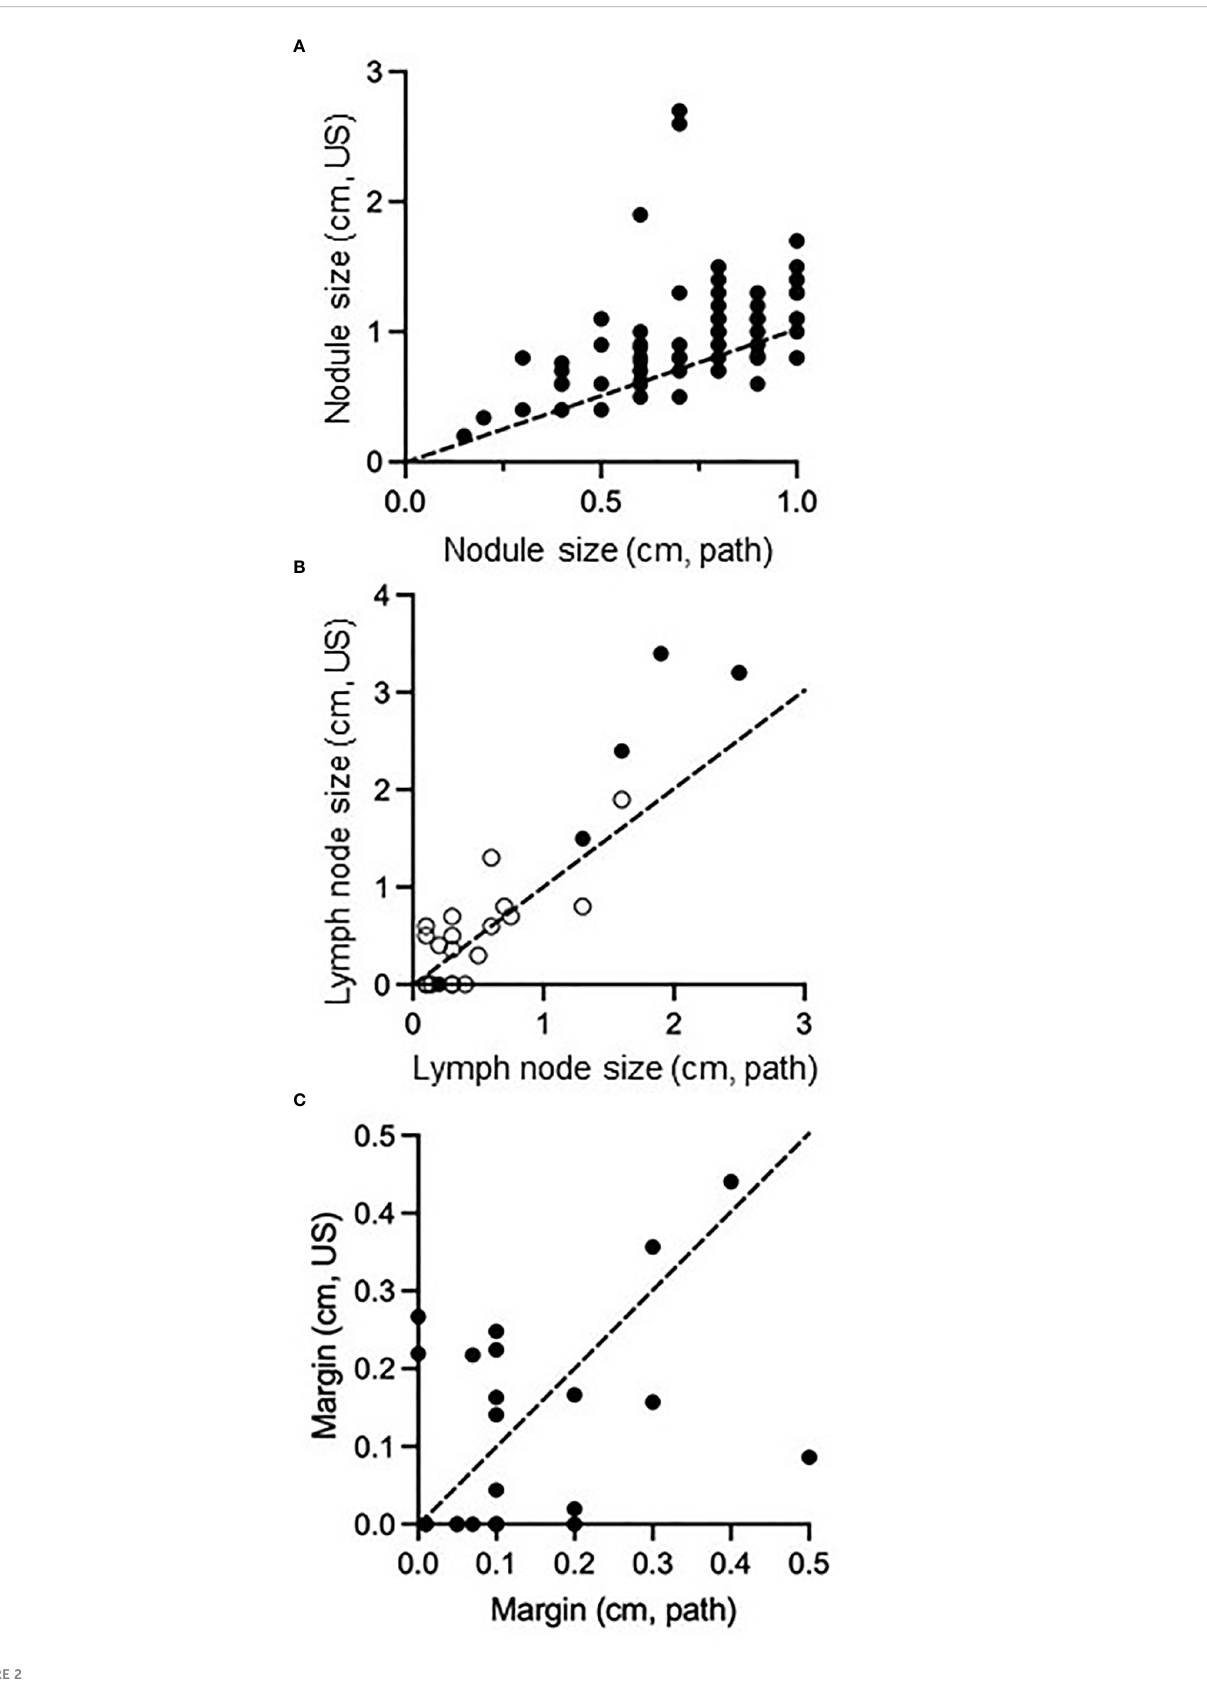
FIGURE 2 Comparison of size of PTMC nodules (A) , size of regional metastatic disease (B) , and distance of tumor margin from thyroid capsule/surgical resection boundary (C) as measured on preoperative ultrasound compared to surgical pathology. Dashed line passes through (0,0) and (1,1), representing equivalent size on both measurements. In (B) , open circles represent central neck nodes and closed circles represent lateral neck